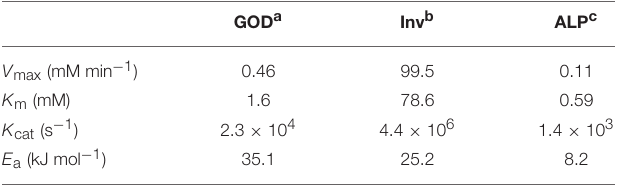
TABLE 2 | Kinetic and thermodynamic parameters of enzymes secreted by Antarctic yeasts.